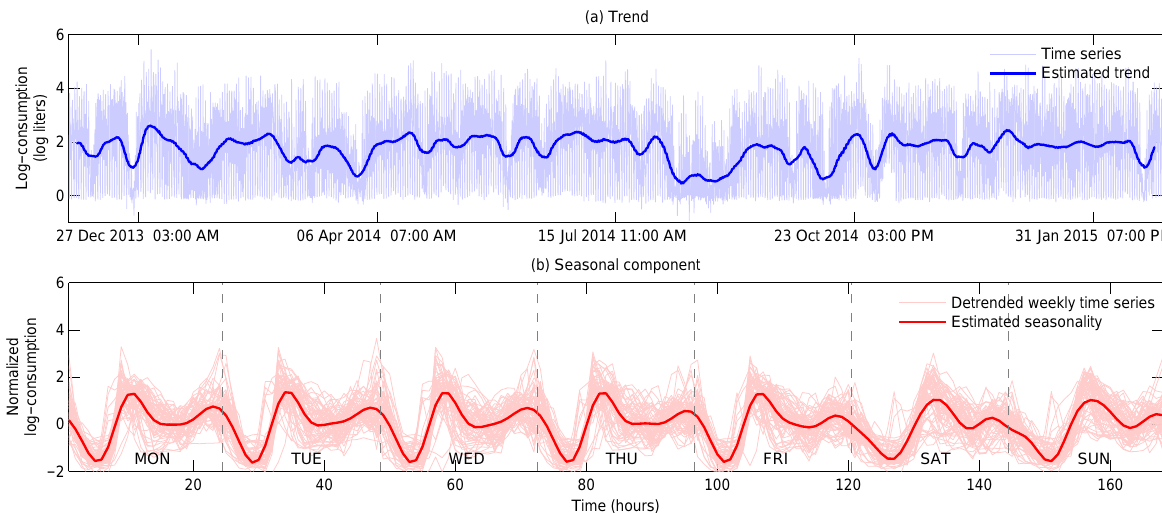
Figure 2. Extraction of periodic seasonal patterns using Fourier-based time series decomposition. The trend is displayed with the complete time series (a) and the seasonal component is displayed with the weekly time series (b)